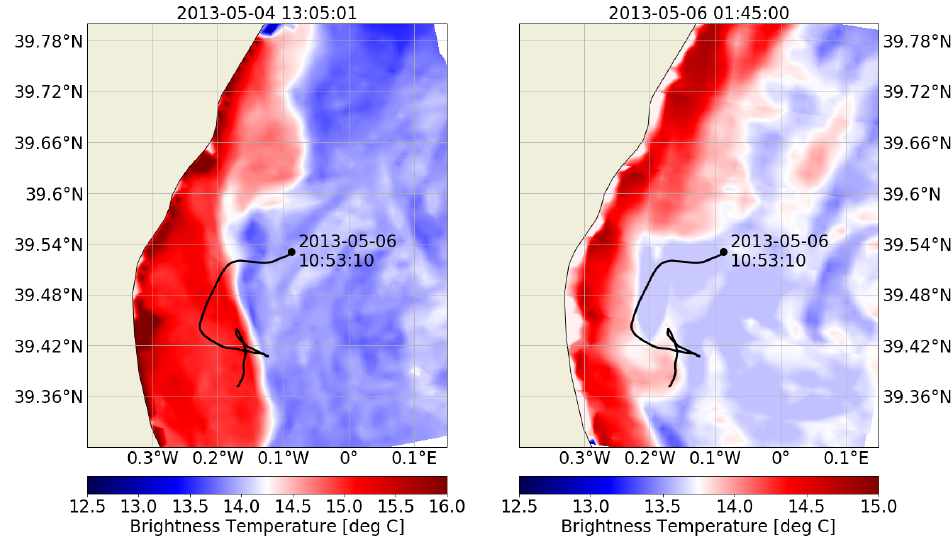
Figure 7. Sequence of thermal images of the southwards propagation of the coastal perturbation in front of the Valencia coast. The solid black line corresponds to the observed trajectory. The dote indicates its initial position.